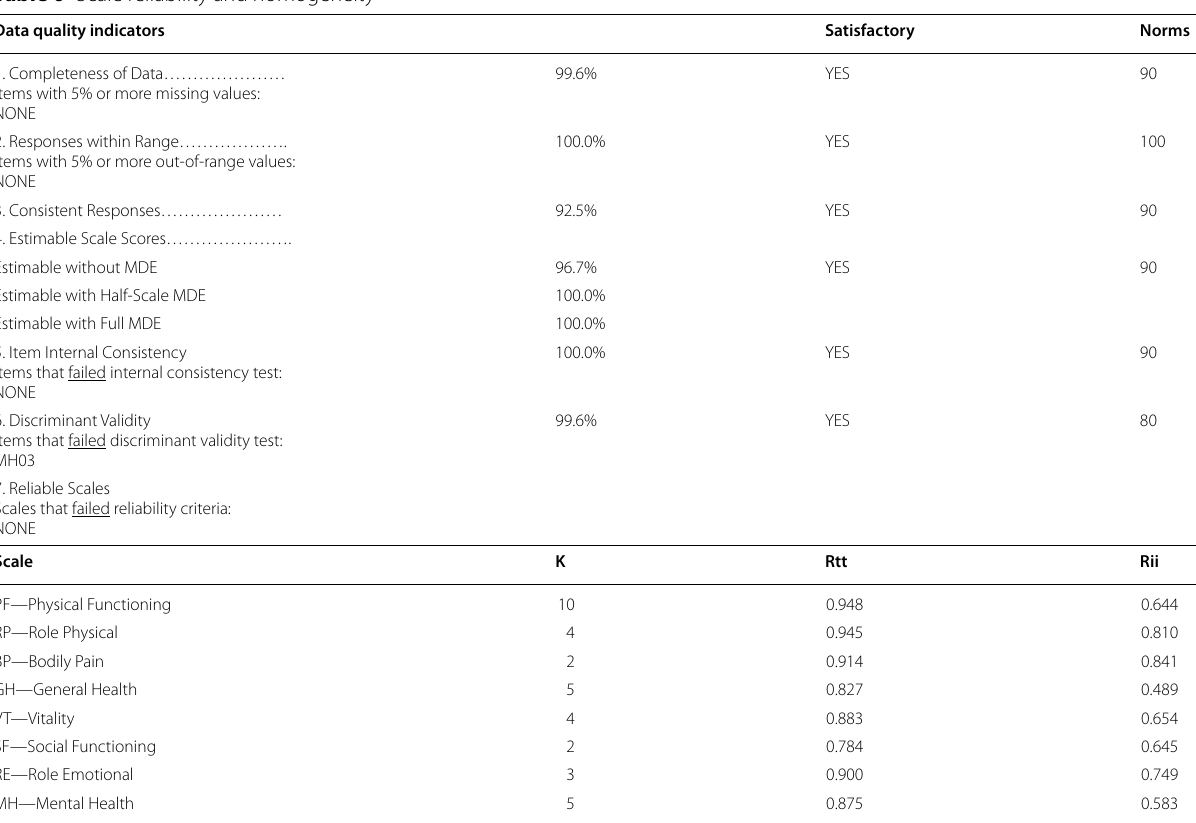
Table 6 Scale reliability and